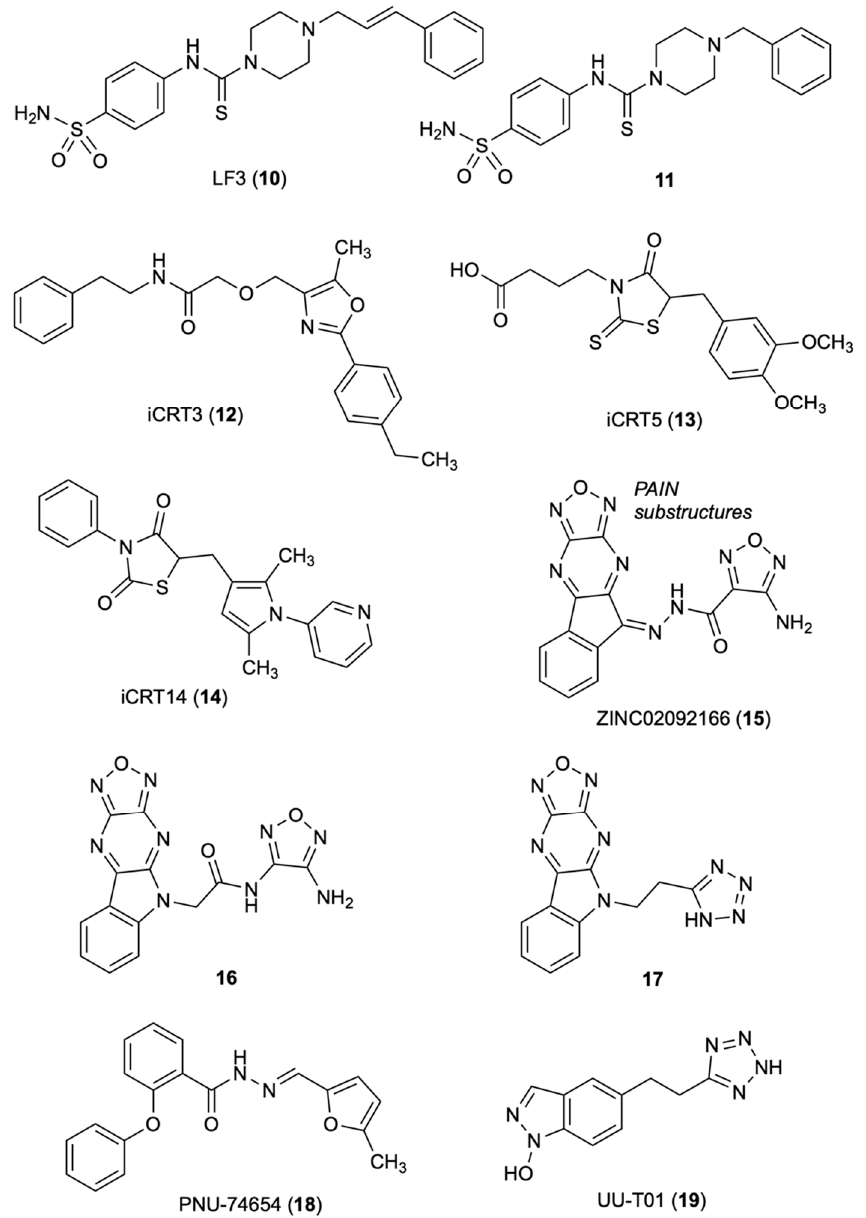
Figure 3. Chemical structures of compounds 10 – 19 inhibitors of β -catenin/Tcf